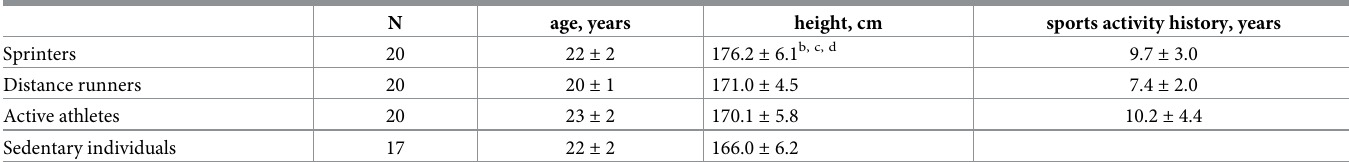
Table 1. Physical characteristics and sport activity history of each subject